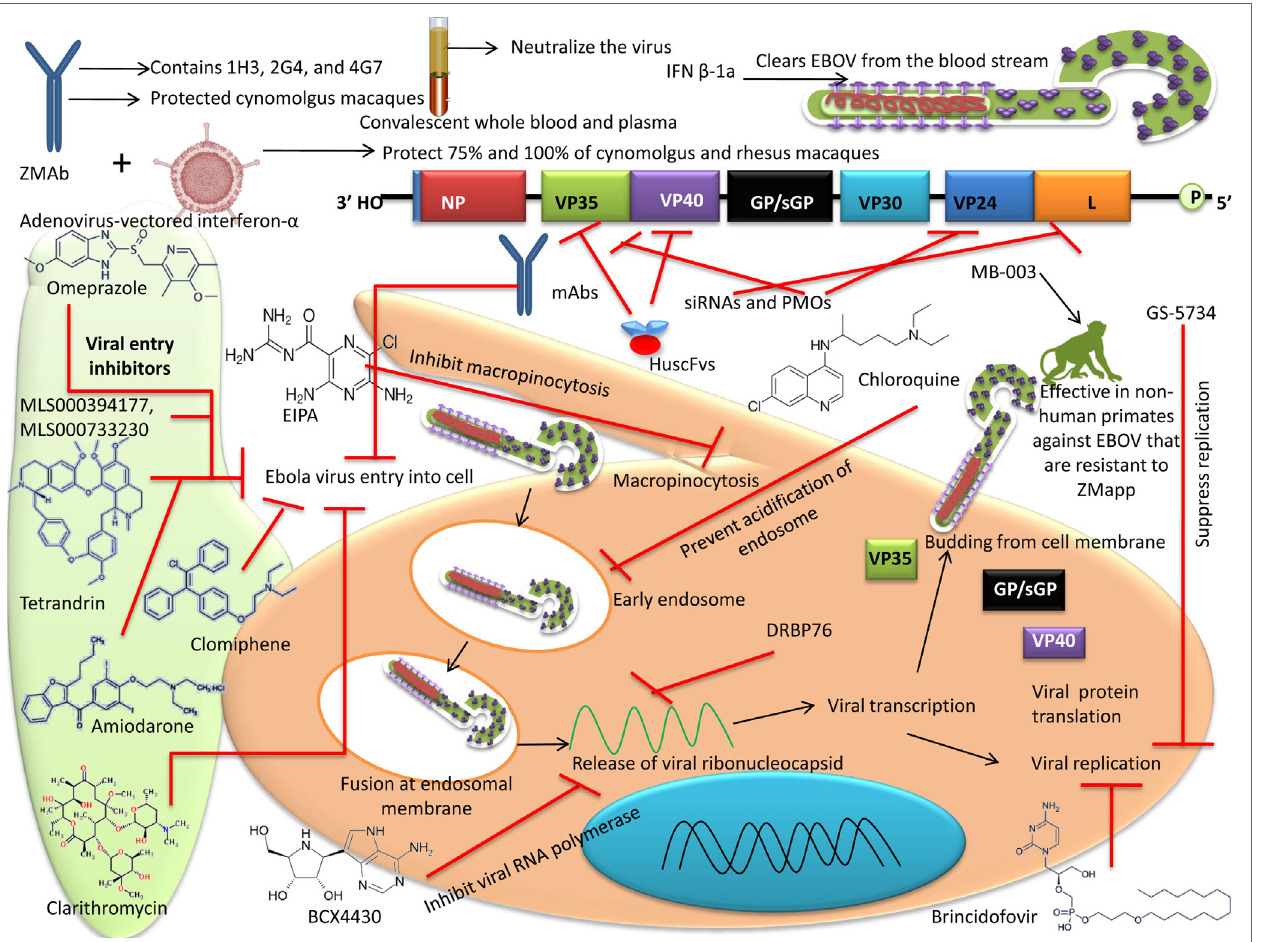
FiGURe 2 | Different therapeutic agents and drugs available for the treatment of Ebola virus disease (EVD). Some agents block the viral entry, some block the RNA polymerase, while some inhibit gene expression. Neutralizing antibodies and mAbs have shown the potential to effectively inhibit Ebola virus